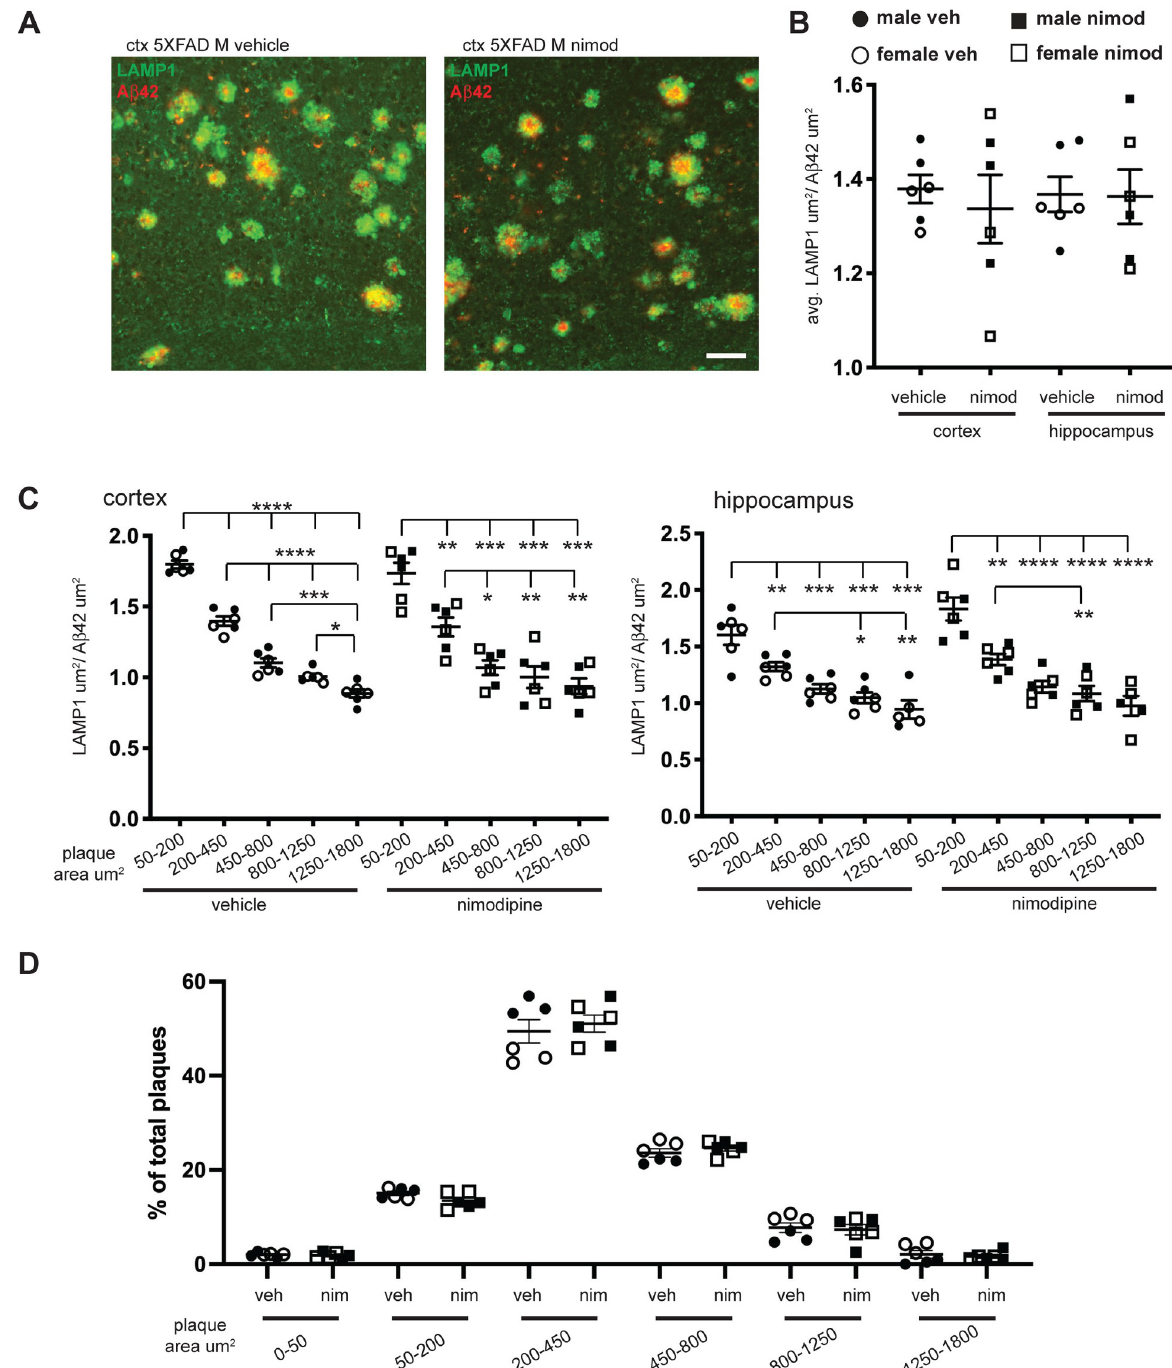
Fig 5. Dystrophic neurites relative to A β 42 are not reduced by nimodipine treatment. ( A) Representative images of sections stained with anti- LAMP1 antibody (green) for dystrophic neurites and anti-A β 42antibody (red) for amyloid plaques. B) Quantification of the ratio of LAMP1:A β 42. Each plaque was defined as a region of interest, and area covered by LAMP1 and A β 42 staining measured and used to calculate LAMP1:A β 42 ratios, then ratios were averaged for plaques in the cortex or hippocampus. There were no significant differences between vehicle or nimodipine- treated mice. C) When plaques were stratified by area of A β 42 staining, we found a clear correspondence between the size of the A β 42 region and the ratio of LAMP1:A β 42, with smaller plaques having higher ratios, indicating a proportionally greater amounts of dystrophic neurites. The decrease in LAMP1:A β 42 ratio with increasing A β 42 area was similar between vehicle and nimodipine-treated mice, with no significant differences between the two groups for any size range of plaques. (D) While the number of plaques per mouse varies, the distribution of plaques over the size range is very consistent between mice and is not affected by nimodipine